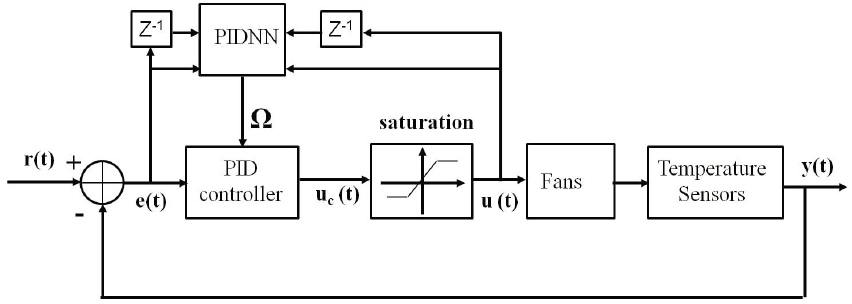
Figure 3. The block diagram of the self-tuning proportional-integral-derivative (PID) control